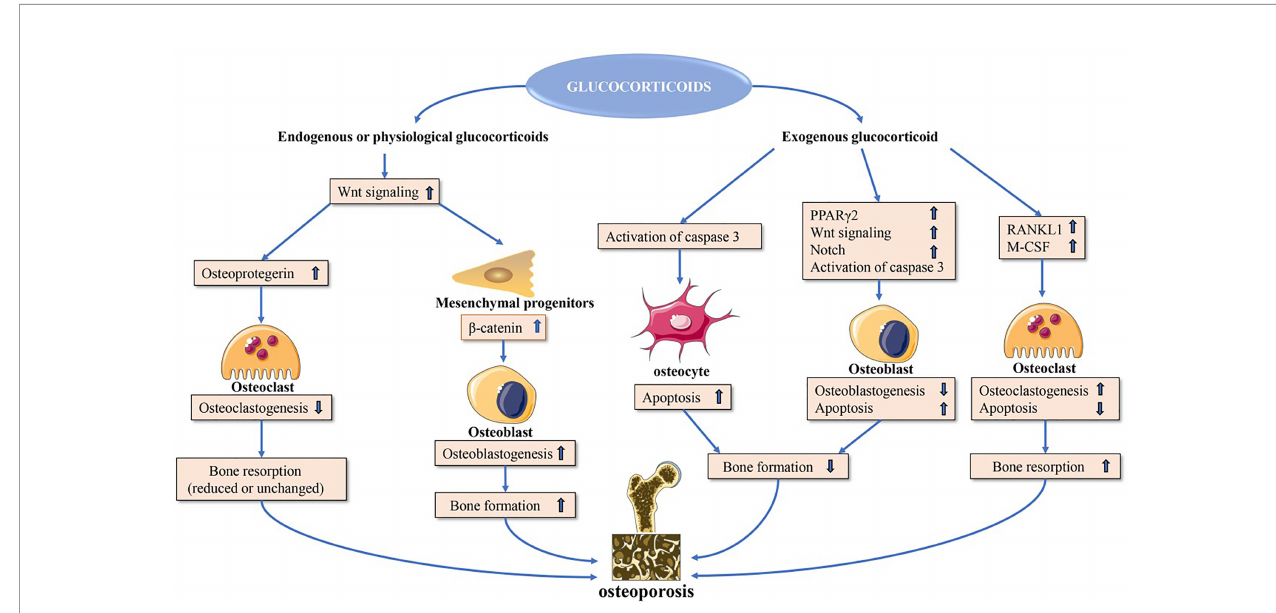
FIGURE 1 | Direct glucocorticoid effects on bone. Endogenous or physiological glucocorticoids stimulate mature osteoblasts to produce canonical Wnt proteins, which activate the b -catenin signaling cascade in mesenchymal progenitor cells and promote them to differentiate towards osteoblasts. These actions favor bone formation. Additionally, Wnt signaling in osteoblasts and osteocytes promotes osteoprotegerin expression, which in turn inhibits osteoclast formation resulting in decreased or unchanged bone resorption. Exogenous glucocorticoids negatively affect osteoblast and osteocyte function. In osteoblasts and osteocytes, increased PPAR g 2 and Notch target gene expression and decreased wnt signaling contribute to decreased osteoblastogenesis, and activation of caspase 3 results in increased osteoblast and osteocyte apoptosis. Glucocorticoids induce upregulation of expression of RANKL and M-CSF, which leads to increased osteoclastogenesis and osteoclast lifespan. PPAR g 2, peroxisome proliferator-activated receptor- g 2; RANKL, receptor activator of nuclear factor- k B ligand; M-CSF, macrophage colony-stimulating